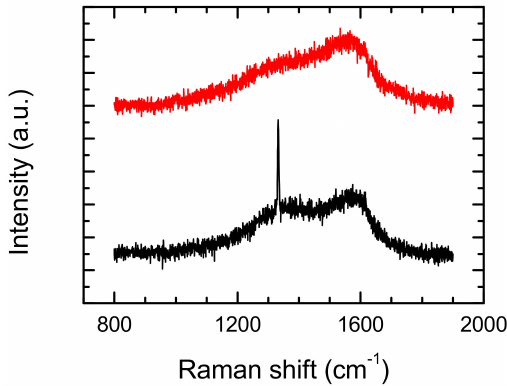
Figure 10. Raman spectra from two places of the laser modified surface at 9.5 W of average power, scan speed 100 mm / s and scan grid 5 × 5 µ m. Diamond peak appears only in one spectrum at 1332.5 cm − 1 with FWHM = 4 cm − 1